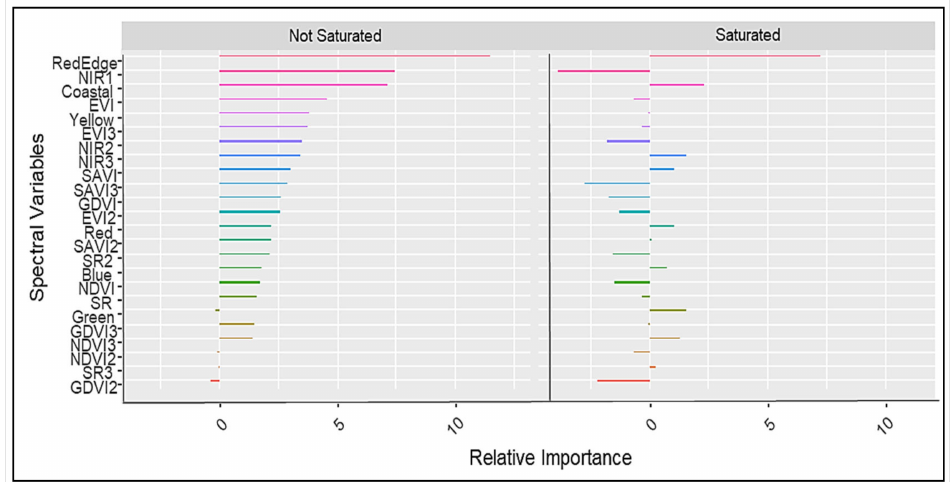
Figure 6. The relative importance of each spectral variable in classifying nitrogen-saturated vs. nitrogen-non-saturated grassland